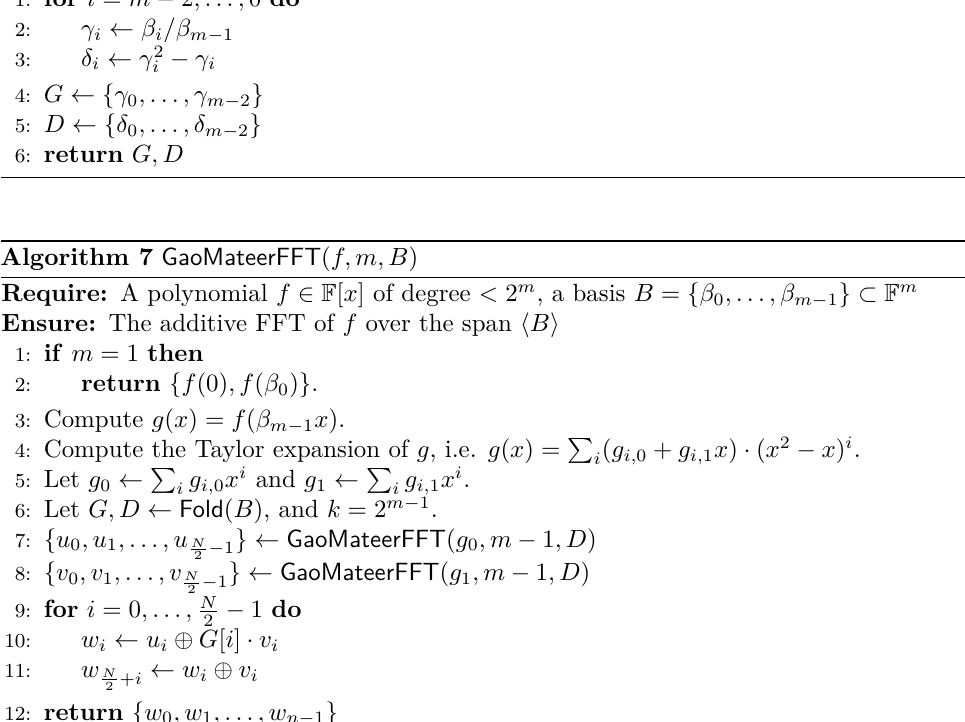
Algorithm 6 Fold ( B )